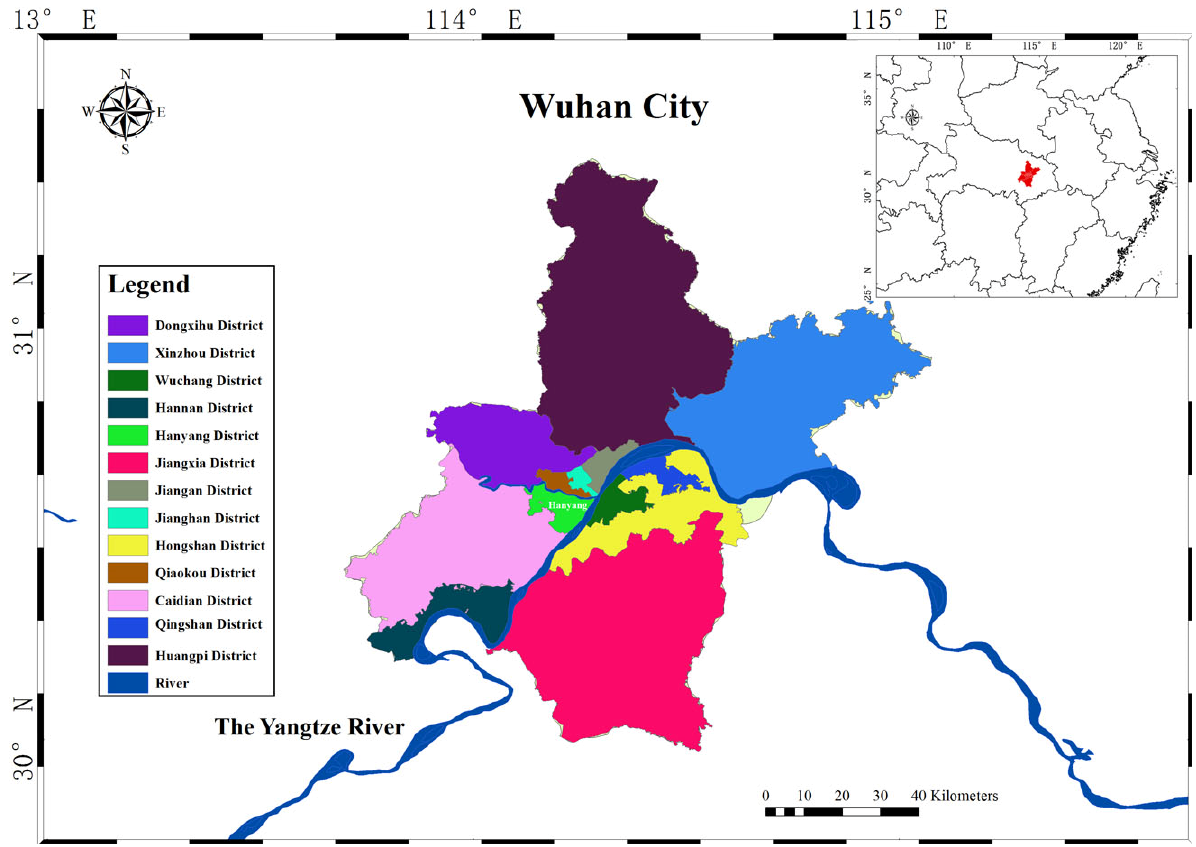
Figure 5. Location of Wuhan city, the city with hundreds of